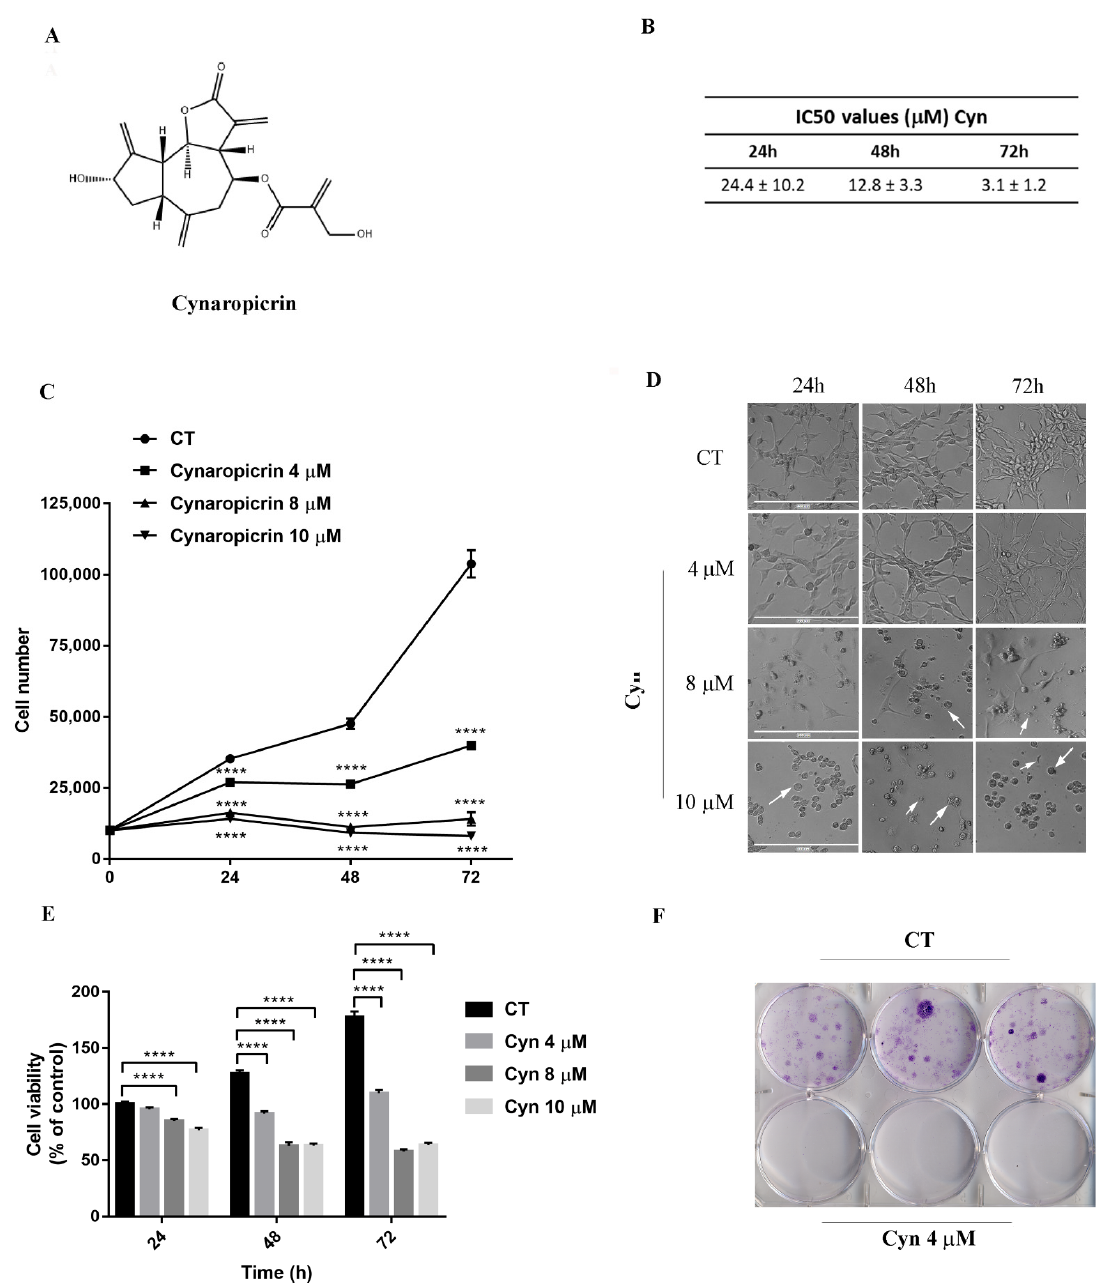
Figure 1. Cytotoxic effects of Cyn on human glioblastoma U-87 MG cells. ( A ) Molecular structure of SL Cynaropicrin (IUPAC name: ([(3 a R,4S,6 a R,8S,9 a R,9 b R)-8-hydroxy-3,6,9-trimethylidene-2-oxo- 3 a ,4,5,6 a ,7,8,9 a ,9 b -octahydroazuleno[4,5- b ]furan-4-yl] 2-(hydroxymethyl)prop-2-enoate). ( B ) Determination of IC50 values on U-87 MG cells using GraphPad Prism 7 software after 24, 48 and 72 h of incubation with Cyn 0.01, 0.1, 1, 10, 25, 50 and 100 µ M and DMSO 0.1% as the vehicle control. ( C ) Dose and time-dependent reduction of the U-87 MG cell number under daily exposure to Cyn 4, 8 and 10 µ M for 24, 48 and 72 h. ( D ) Morphological change of 4, 8 and 10 µ M Cyn-treated U-87 MG cells for 24, 48 and 72 h. White arrows indicate round-shaped cells with a loss of filaments and the presence of cell shrinkage. ( E ) Cytotoxic effects of daily exposure to Cyn 4, 8 and 10 µ M for 24, 48 and 72 h on the U-87 MG cell metabolism. ( F ) Effect of Cyn 4 µ M on the U-87 MG clonogenic potential. For all the experiments, values are the mean ± SEM of 3 individual determinations. One-way ANOVA test, p -value < 0.05. According to GraphPad Prism 7 software, **** p -value < 0.0001 (extremely